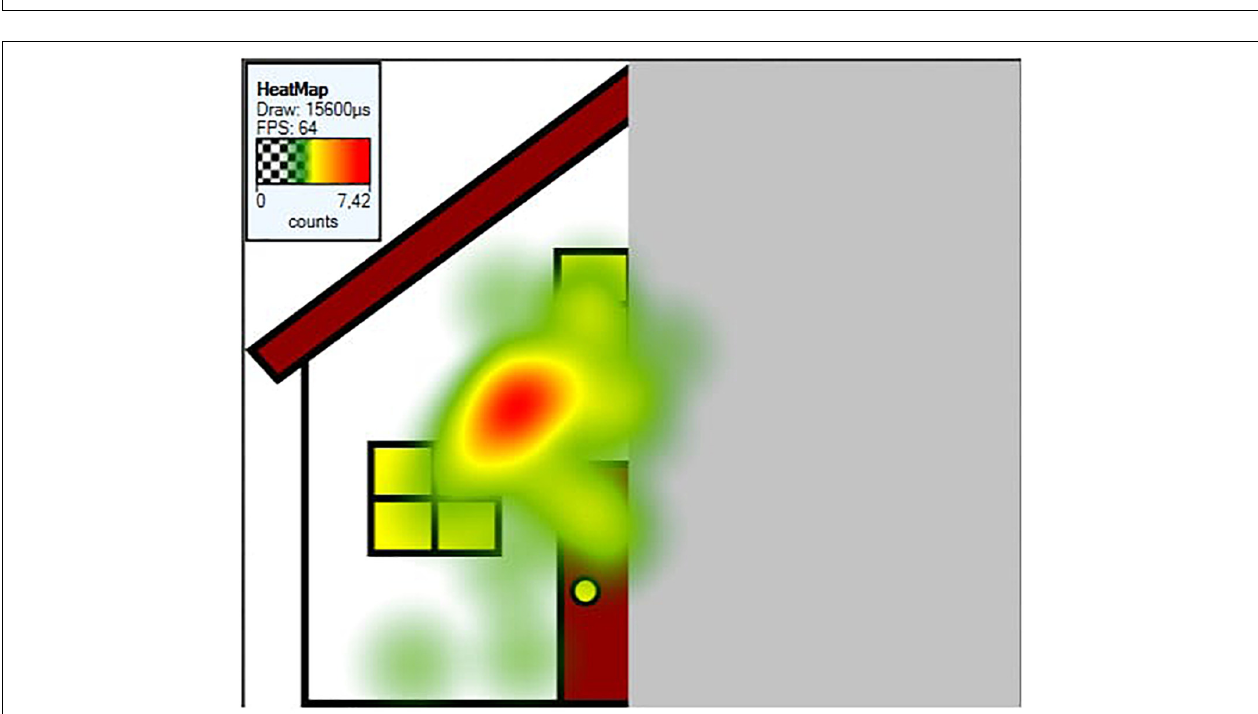
FIGURE 12 | Fixation heatmap of a left upright house stimulus.